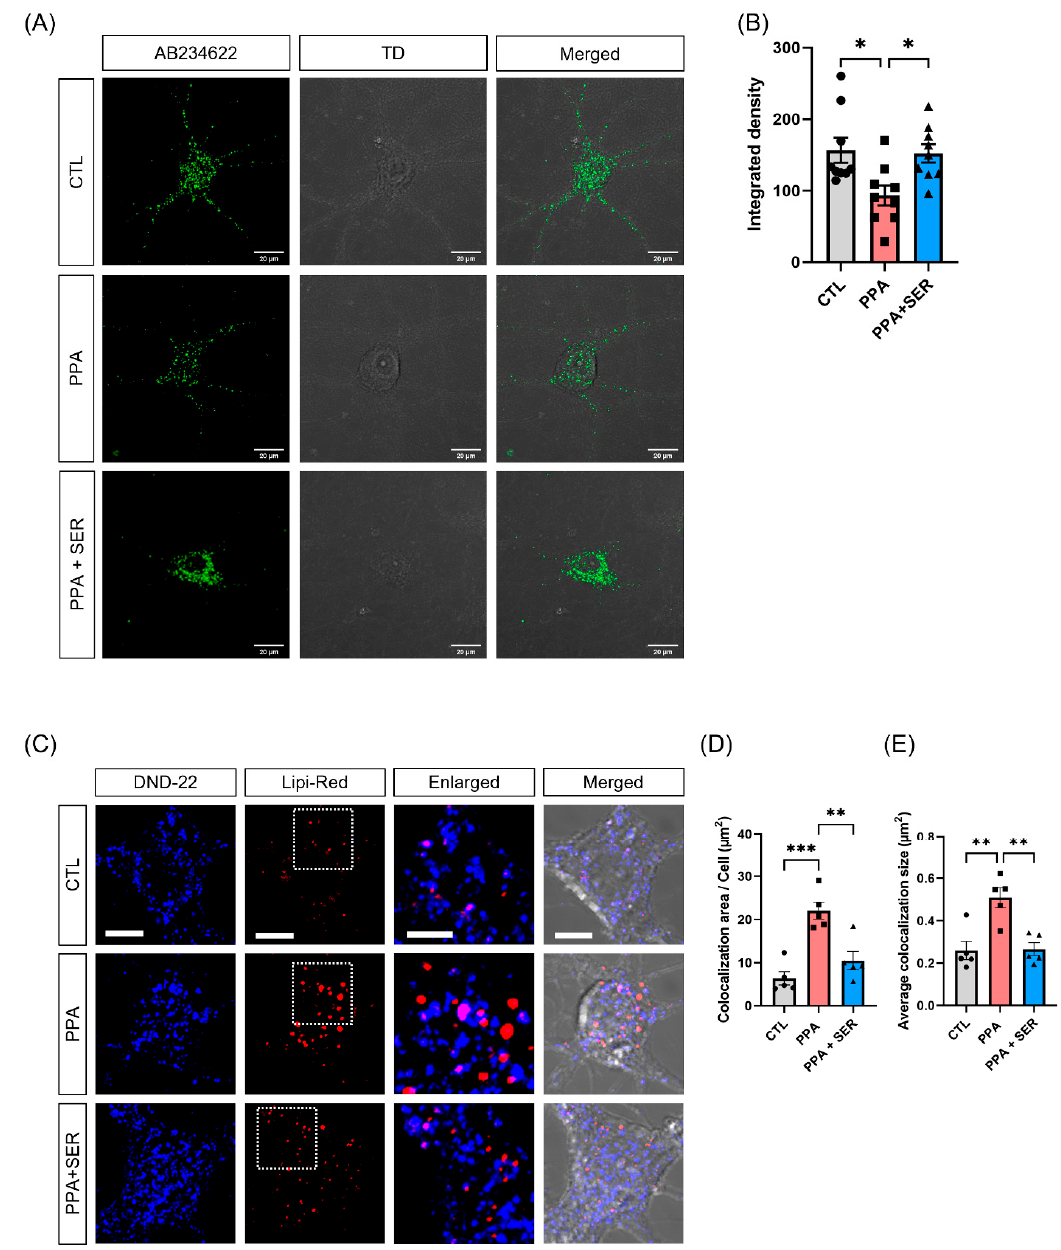
Figure 5. L-serine (SER) reduced the colocalization of lysosomes and lipid droplets against PPA. ( A ) Representative fluorescence images of the release of the self-quenched substrate in hippocampal neurons ( n = 8). Confocal images showed lysosomal activity with green fluorescence. Scale bar, 20 µ m. ( B ) Quantification of the integrated density in hippocampal neurons. PPA significantly reduced lysosomal activity compared to control. L-serine (SER) significantly increased lysosomal activity compared to PPA. * p < 0.05 by one-way ANOVA, Tukey’s multiple-comparison test. TD: transmitted light detector image. AB234622: Lysosomal intracellular activity assay kit. ( C ) Representative fluorescence images of colocalization of lysosome and lipid droplets (LD) in hippocampal neurons. Blue fluorescent signals represent lysosomes, and red fluorescent signals represent lipid droplets (LD). Scale bar, 10 µ m; 5 µ m (the magnified images). ( D , E ) Quantification of total area ( D ) and average size ( E ) of colocalization of lysosomes and lipid droplets (LD) in hippocampal neurons. ** p < 0.01, *** p < 0.001 by one-way ANOVA, Tukey’s multiple-comparison